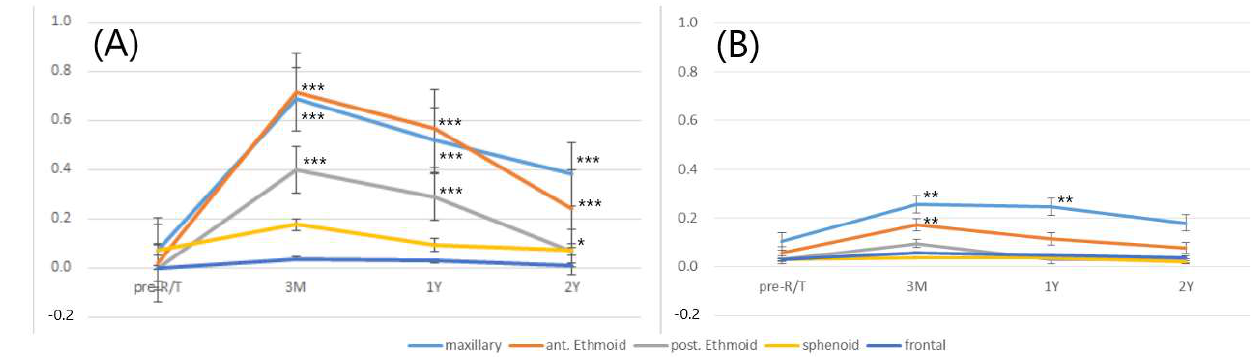
Figure 2. Mean values of the Lund–Mackay scores for individual sinuses in patients with nasopharyngeal carcinoma before and after volume-modulated arc therapy ( A ) and intensity-modulated proton therapy ( B ) in different follow-up periods. (*** p < 0.001, ** p < 0.01, and * p < 0.05).